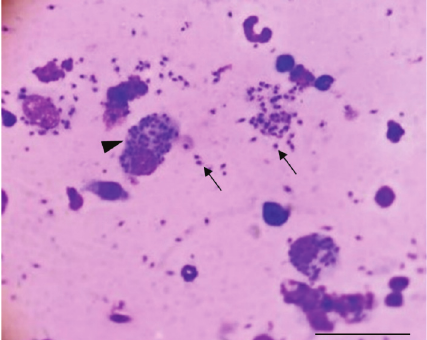
Figure 2: Microscopic examination of a fine needle aspirate of a cutaneous nodule from a Leishmania -positive dog (modified MGG) revealing intramacrophages (arrowhead) and extramacrophages (arrows) Leishmania infantum amastigotes. Bar � 60 µ m.